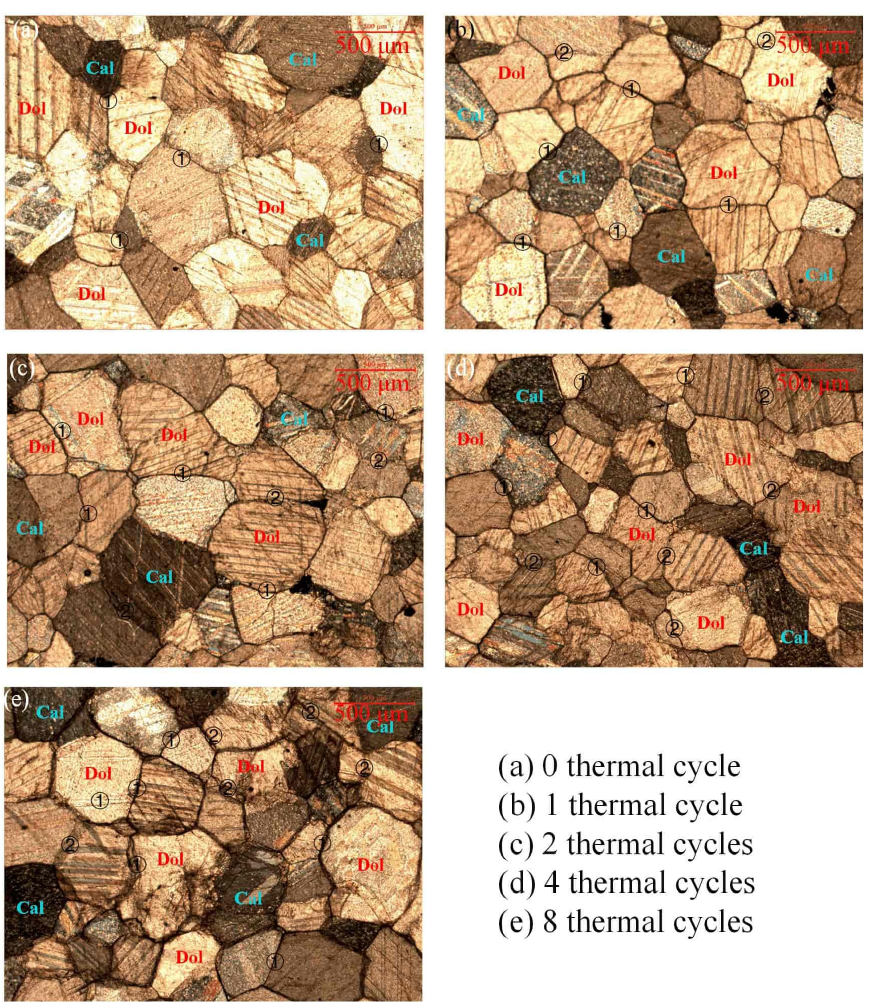
Figure 19. Microstructure of rock specimens after different cycles of thermal cycle treatment ( ① grain boundary microcracks, ② intra ‐ granular microcracks).